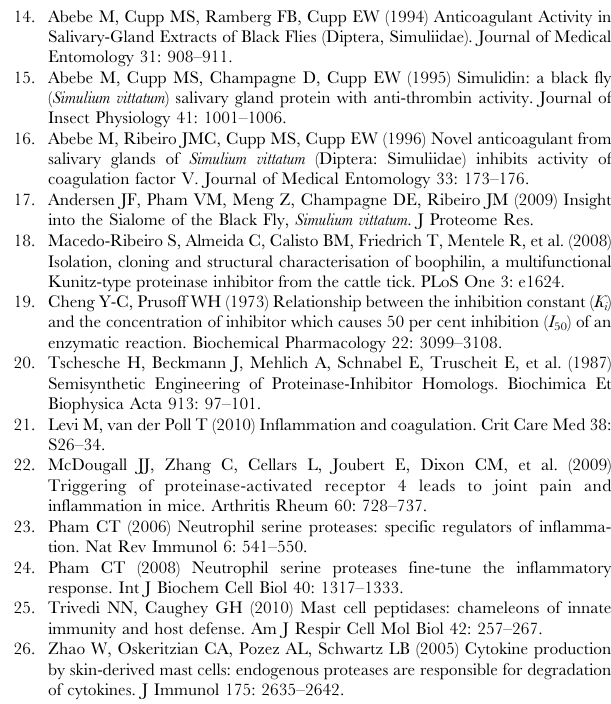
Table S1 PCR primers used in this study. For primers used for cloning in pET-30, direction-specific LIC sites are underlined. For primers used for single His-tag constructs, bold letters indicate the stop codon (TAA) and the read-through Ala (GCA in reverse-complement